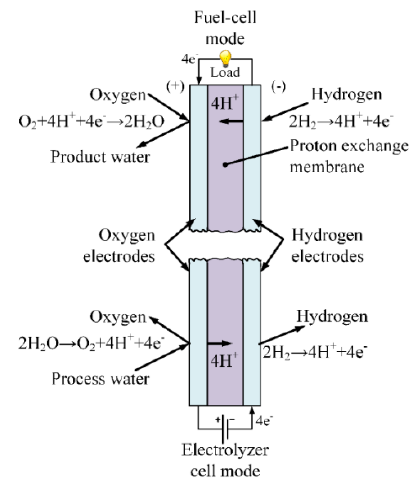
Figure 72. Example of a regenerative fuel cell; it stores electrical energy utilizing hydrogen as the